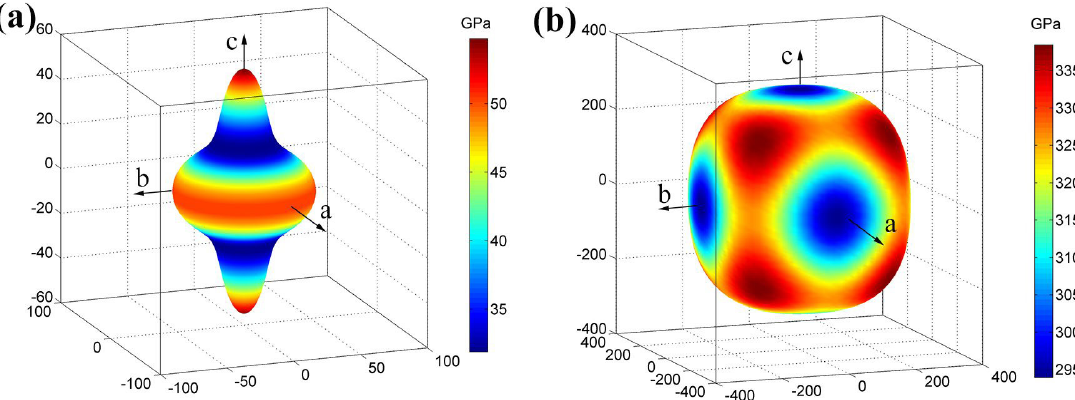
Figure 5 . Three-dimensional diagrams of the Young’s modulus of Mg and MgO phase: (a) Mg; (b) MgO